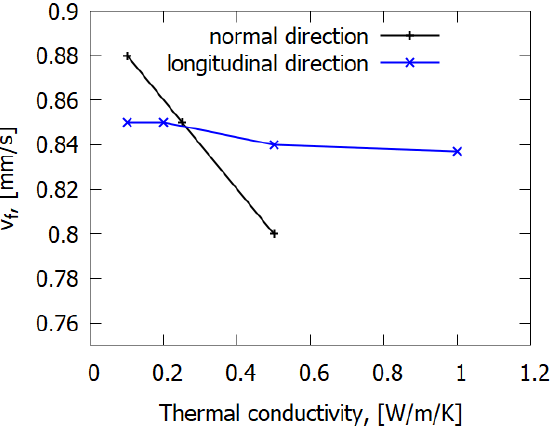
Figure 12. The effect of thermal conductivity in the longitudinal direction and in the normal direction on the flame spread rate. h = 0.3 mm, 25% O 2 .